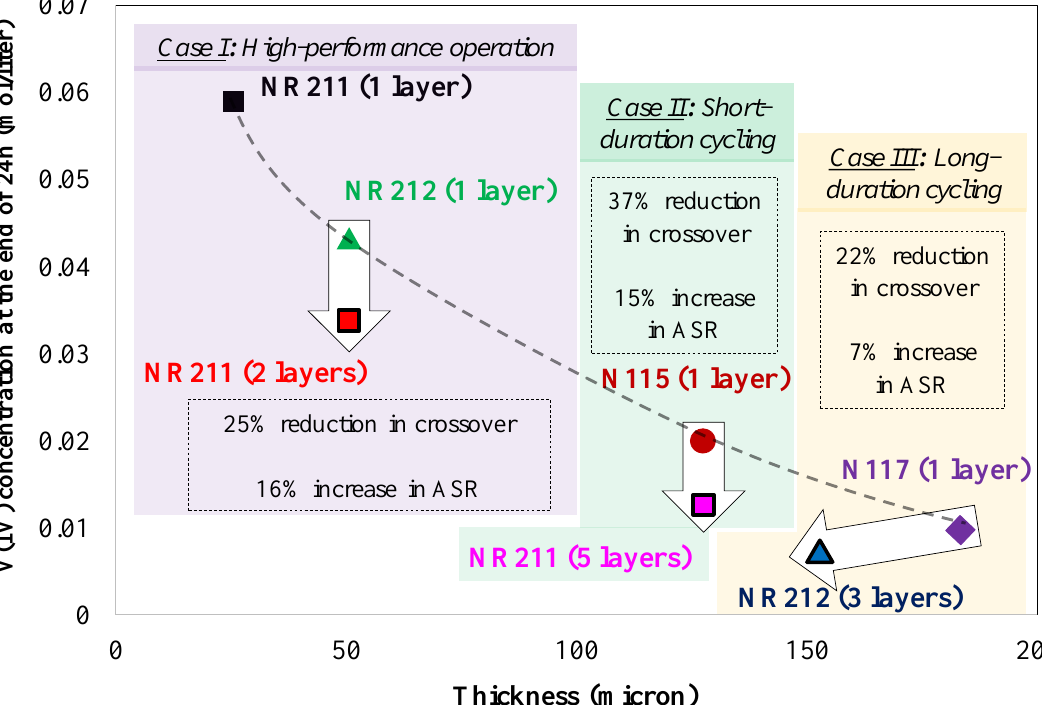
Figure 13. IEM selection chart for reducing ionic crossover in VRFBs. Dashed line represents an exponential fit to the experimentally measured vanadium ion (V(IV)) crossover data associated with the cells with single-layer Nafion ® membrane. The large white arrows demonstrate the improvement in capacity retention with multilayer thinner IEMs for different scenarios including high-performance operation as well as short- and long-duration cycling.